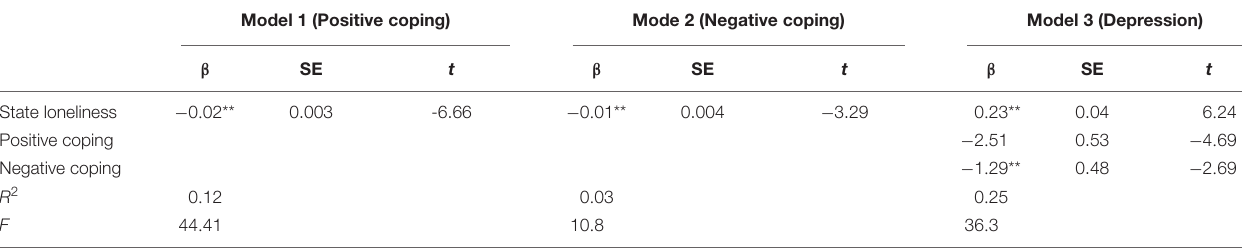
TABLE 2 | Regression analysis of state loneliness, positive coping style, and